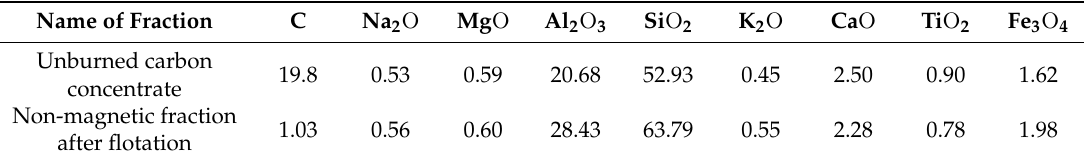
Table 4. The chemical composition (wt %) of the unburned carbon concentrate and non-magnetic fraction after flotation kinetics tests for 40–71 µ m particle size of